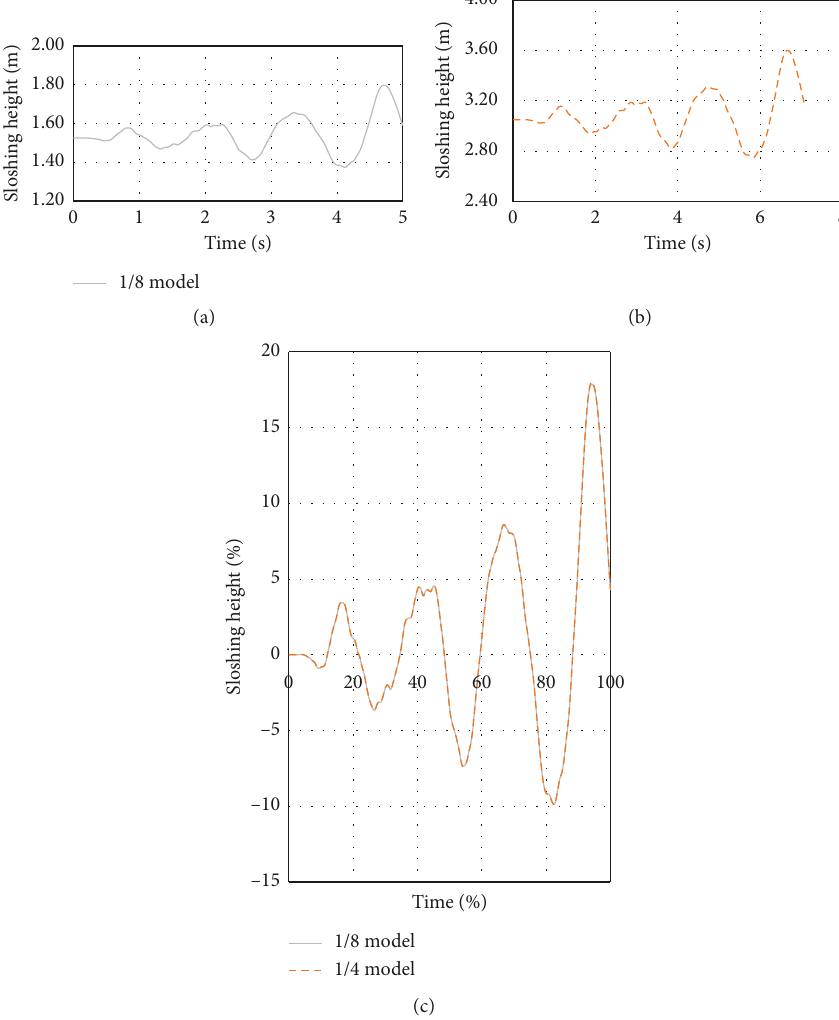
Figure 6: Sloshing heights in (a) 1/8 mode and (b) 1/4 model. (c) Comparison of sloshing heights under